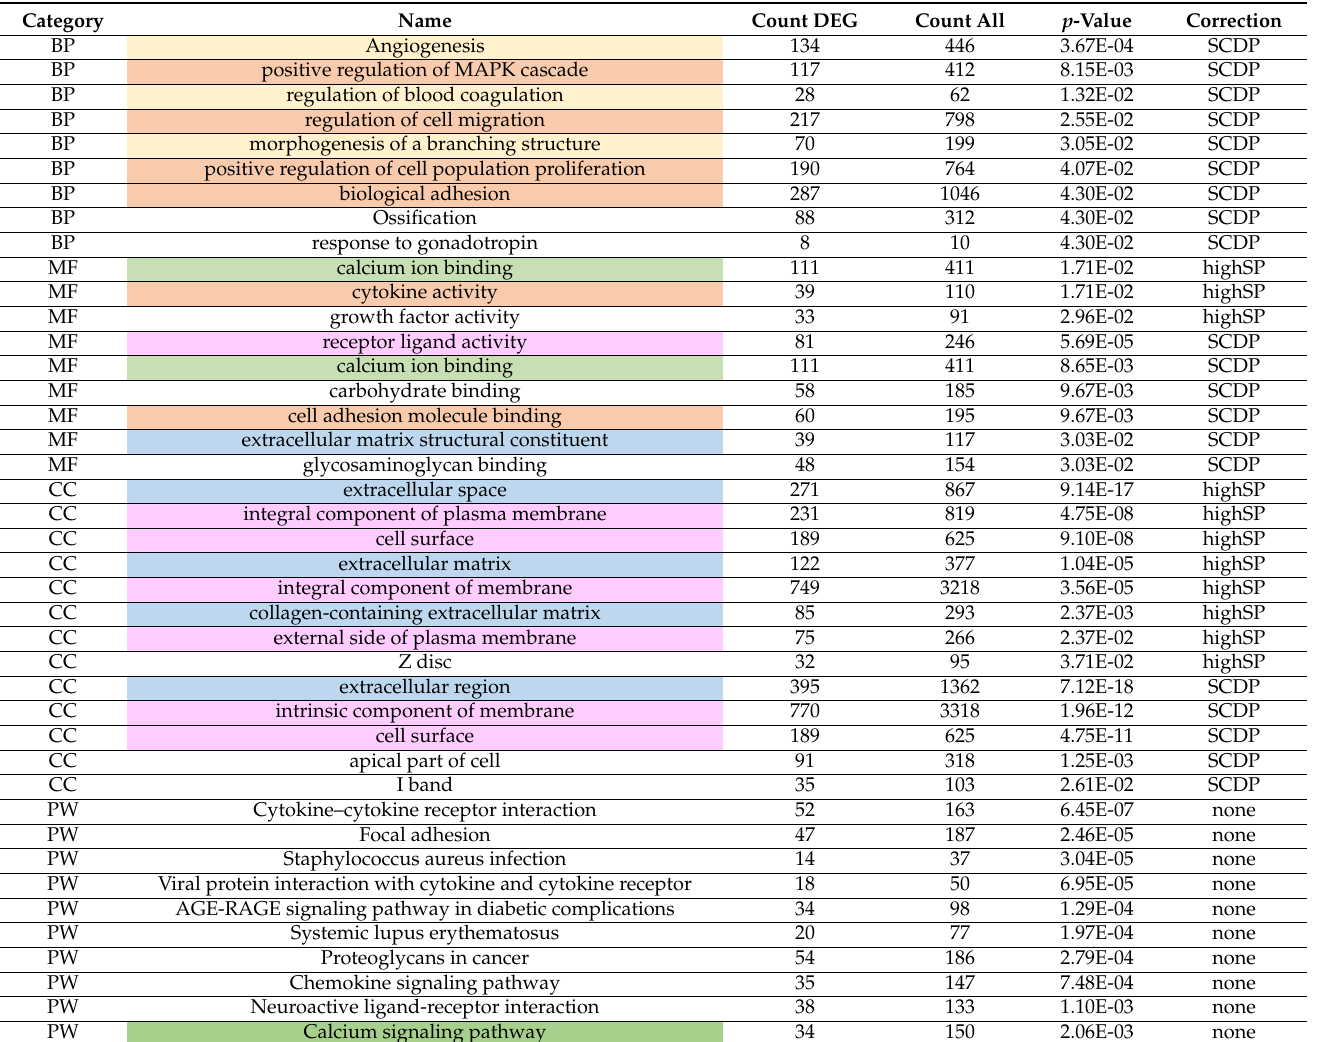
Table 1. Functional enrichment analysis. The enrichment analysis performed on iPathwayGuide includes gene ontology (GO) and pathway (PW) analyses. GO analysis was performed using 2 corrections: the high specificity pruning (highSP) and the smallest common denominator pruning (SCDP) corrections. BP: biological process, MF: molecular function, CC: cellular component. The impacted pathway analysis was performed without any correction: PW: pathway. Only the top 10 most enriched pathways are listed here. For a full list, see Supplementary Table S2. Yellow: Angiogenesis related terms, orange: MAPK signaling and downstream pathways affected by it, green: calcium ion binding, pink: components of the plasma membrane including receptor and ligand activity, blue: ECM-related